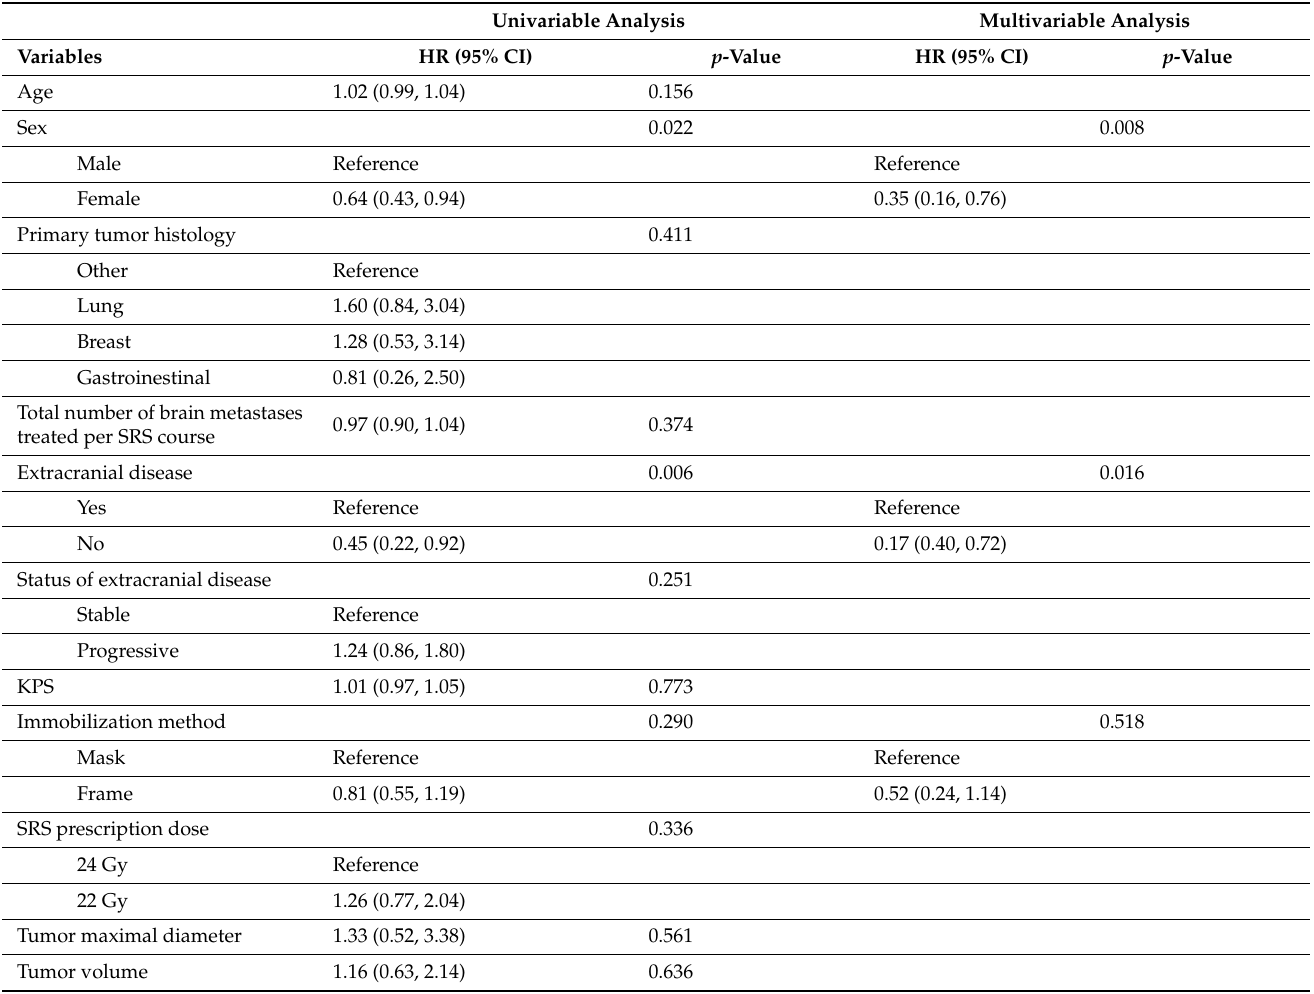
Table 2. Univariable and multivariable analyses for local failure. Univariable Analysis Multivariable